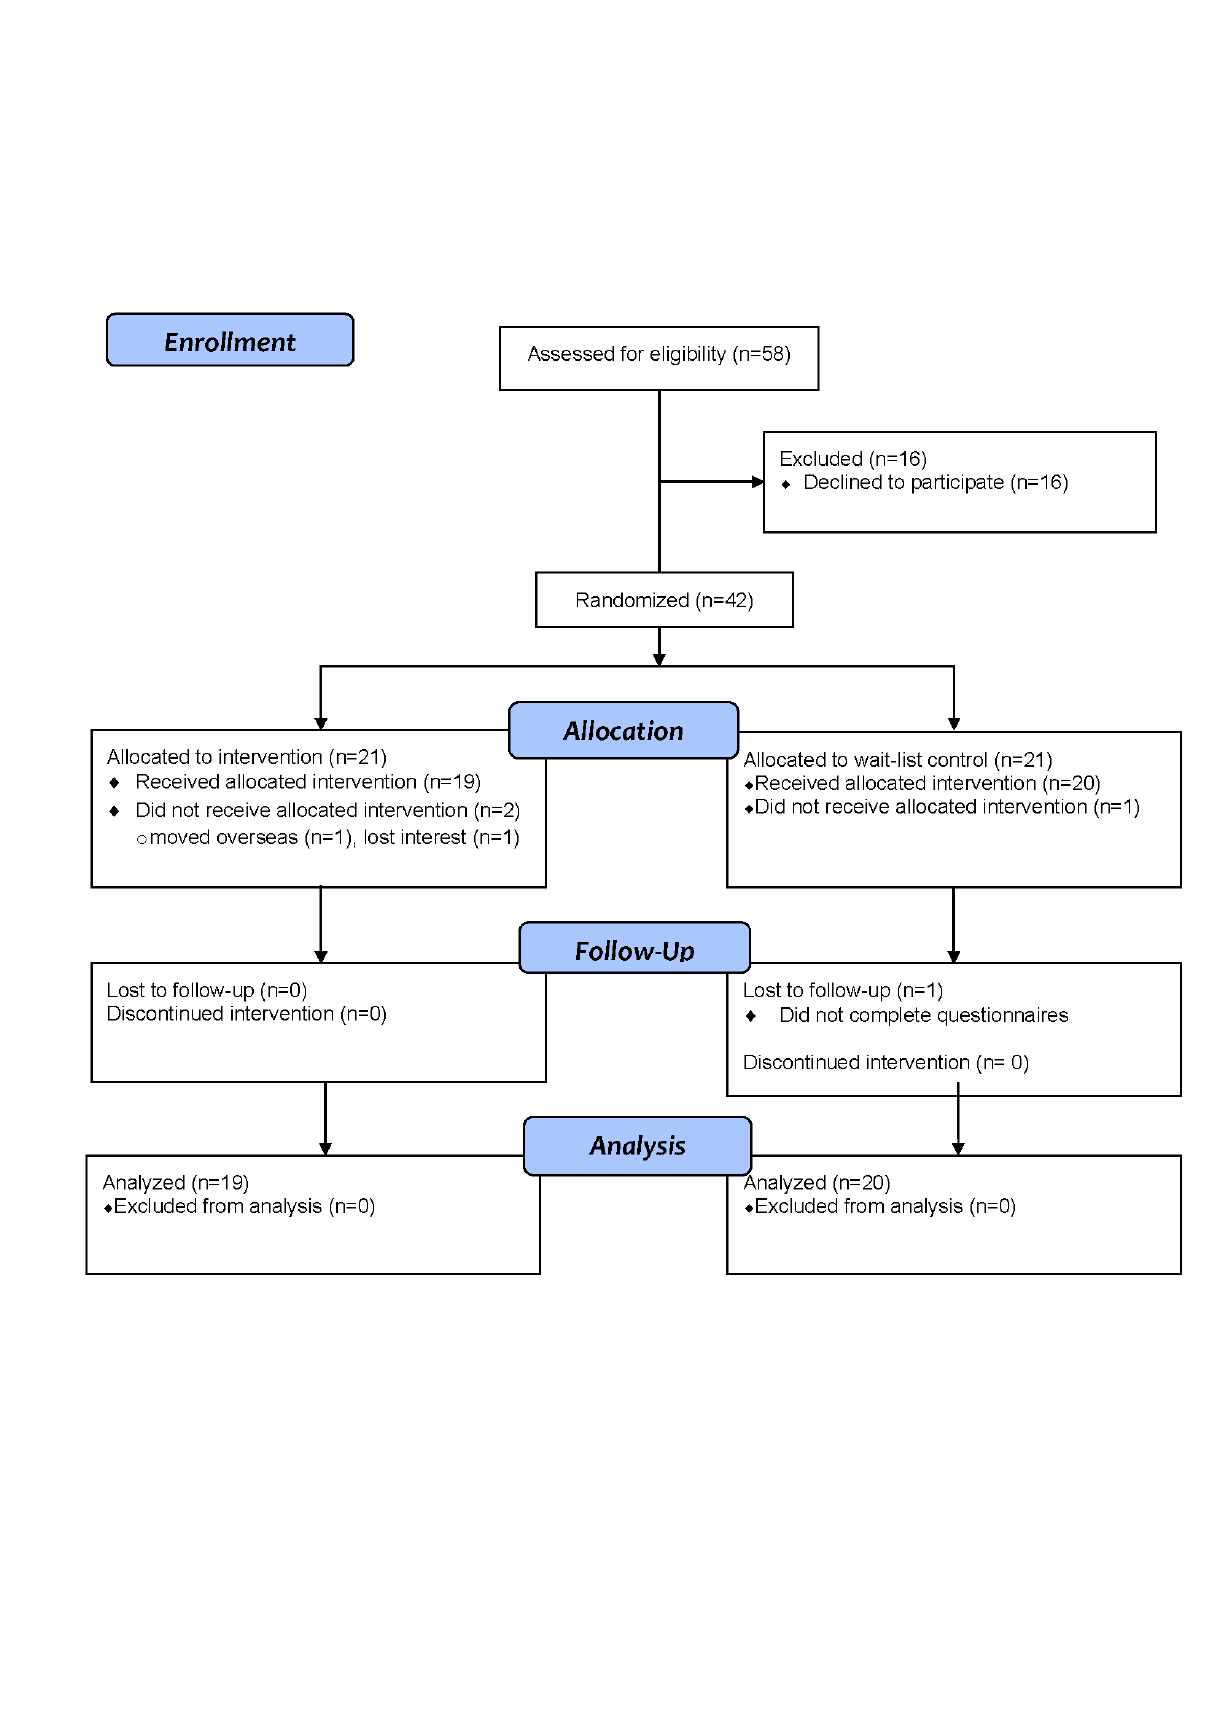
Figure 2. CONSORT flow diagram for the randomized controlled trial of the Breathe Easier Online